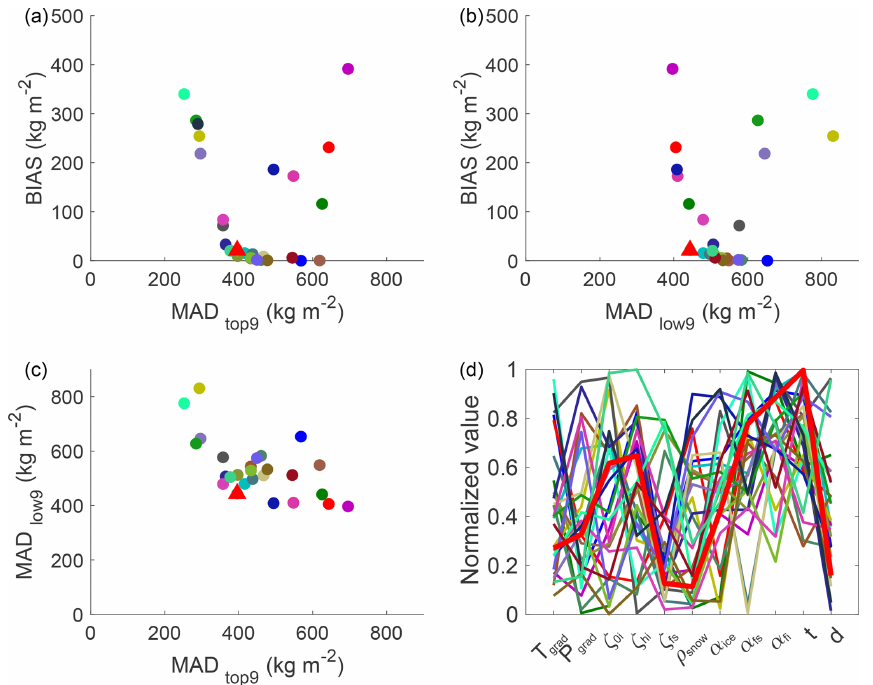
Figure 5. Each individual member of the Pareto set for HEF in 2012 is displayed with a different colour and the compromise solution highlighted (red triangle or red line). The different panels are the 2-dimensional projections of the Pareto space onto the (a) BIAS and MAD top9 ; (b) BIAS and MAD low9 ; and (c) MAD low9 and MAD top9 planes. Panel (d) shows the normalized parameter values for each case in the same colours as in the Pareto space plots. The parameter settings of the optimal solutions are quite diverse and span over most of the parameter space. The firn albedo and albedo timescale are the only parameters showing some confinement to a narrower range. The chaotic nature of the parameter settings furthermore shows that a single solution is not representative in its parameter settings for the ensemble of optimal